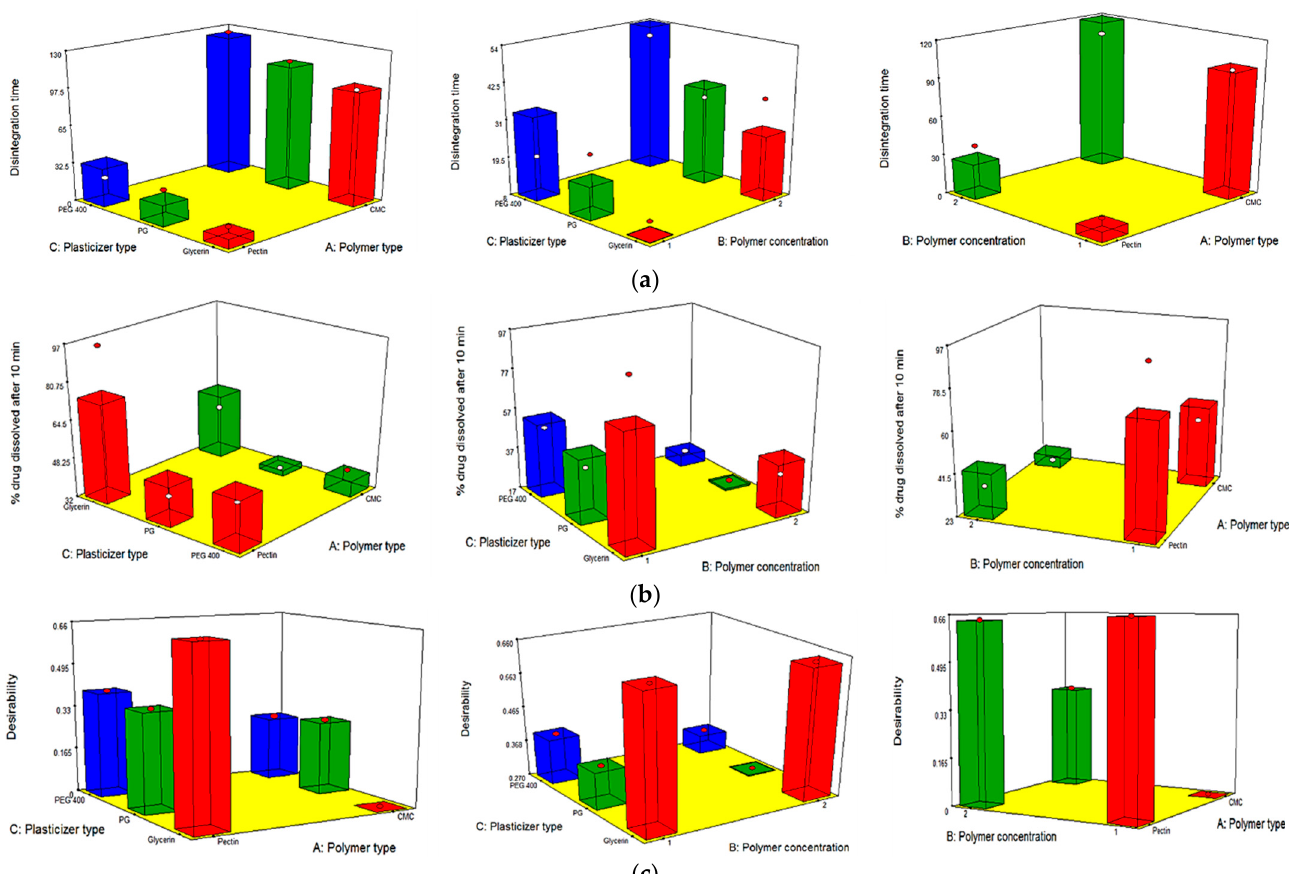
Figure 3. Response 3-D plots for the effect of polymer type (X 1 ), polymer concentration (X 2 ), and plasticizer type (X 3 ) on ( a ) disintegration time, ( b ) % PX dissolved after 10 min, and ( c ) desirability of OFDFs loaded with PX nanosuspension.